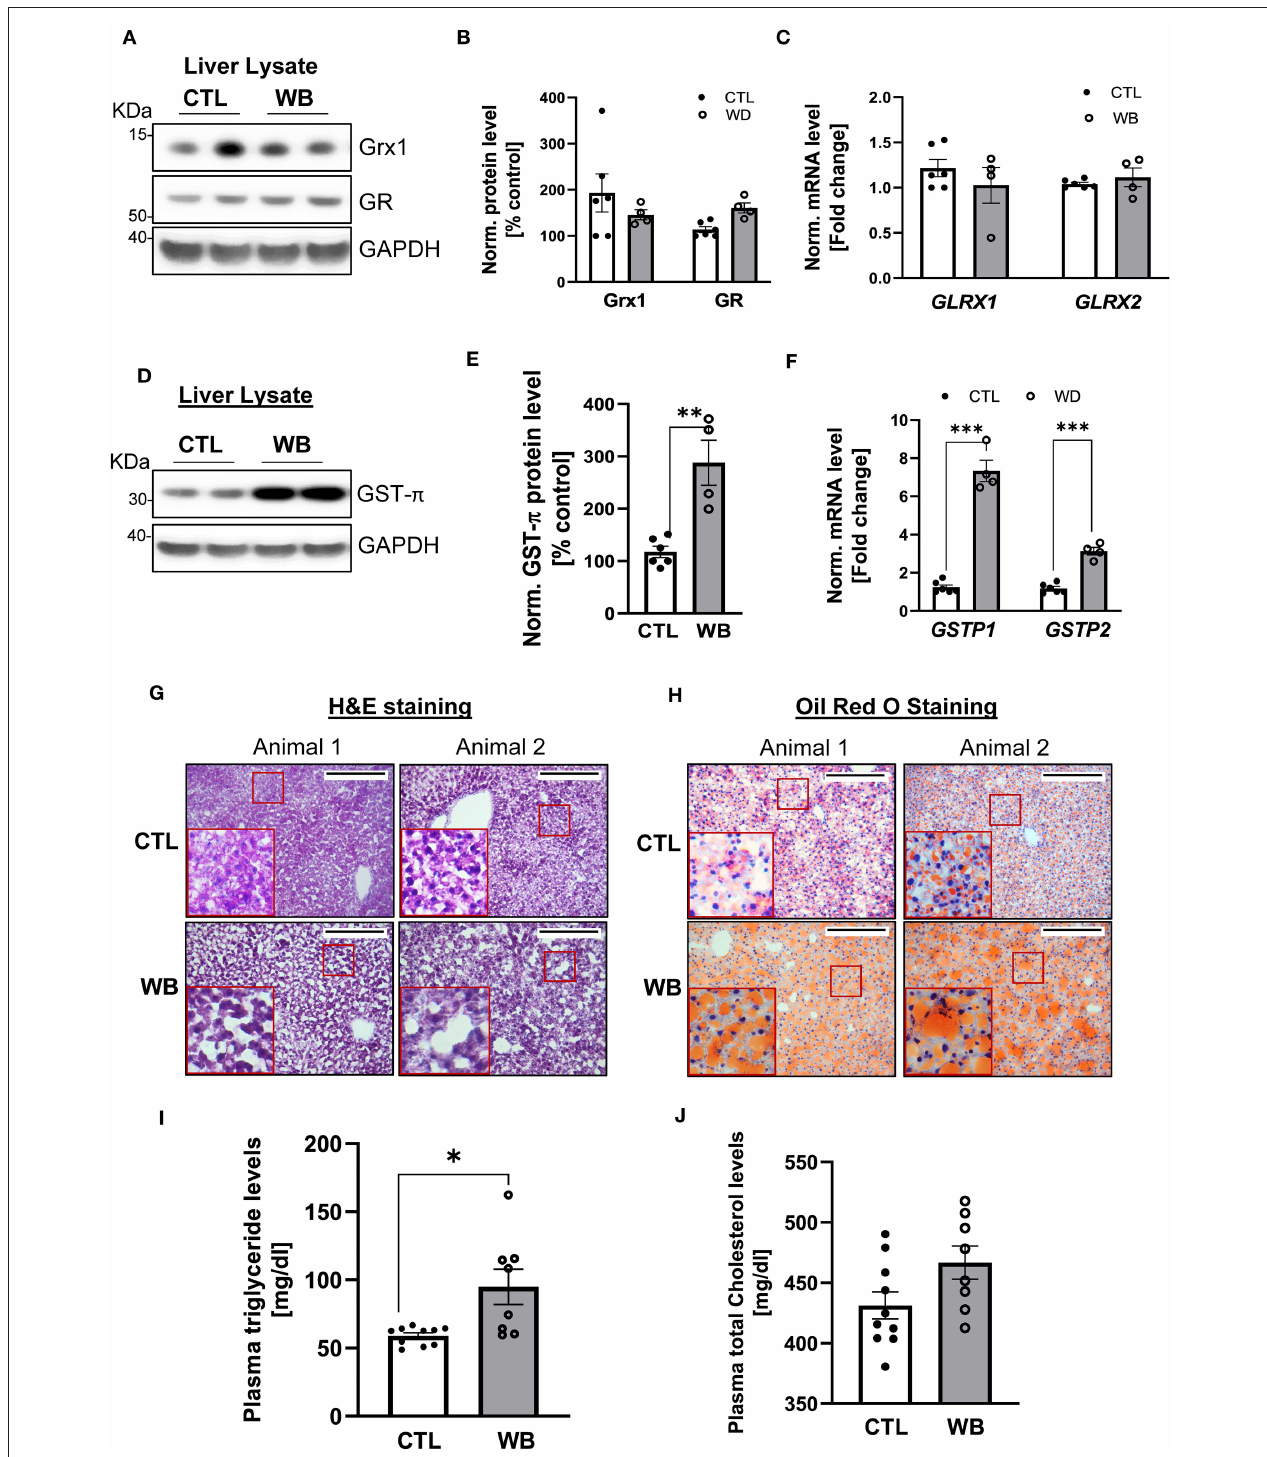
FIGURE 5 | In liver tissue, GST- π expression and lipid accumulation is increased in weekend-binge ethanol-fed ApoE − / − mice compared with the control group. Liver tissue homogenate from control (CTL) and weekend-binge (WB) ethanol-fed mice were assessed for the expression of Grx1, GR and GST- π . (A–C) Grx1 and GR level were not significantly altered by ethanol feeding compared with the control group (A,B) either on protein nor (C) mRNA expression level. Only GST- π was markedly increased (D,E) on protein and (F) mRNA level. (G,H) Liver histology of control (CTL) and weekend-binge (WB) ethanol-fed ApoE − / − mice are performed on 10 µ m frozen sections and shown in (G) Hematoxylin-eosin staining and (H) Oil Red O staining a stronger accumulation of lipids in the weekend-binge group compared to